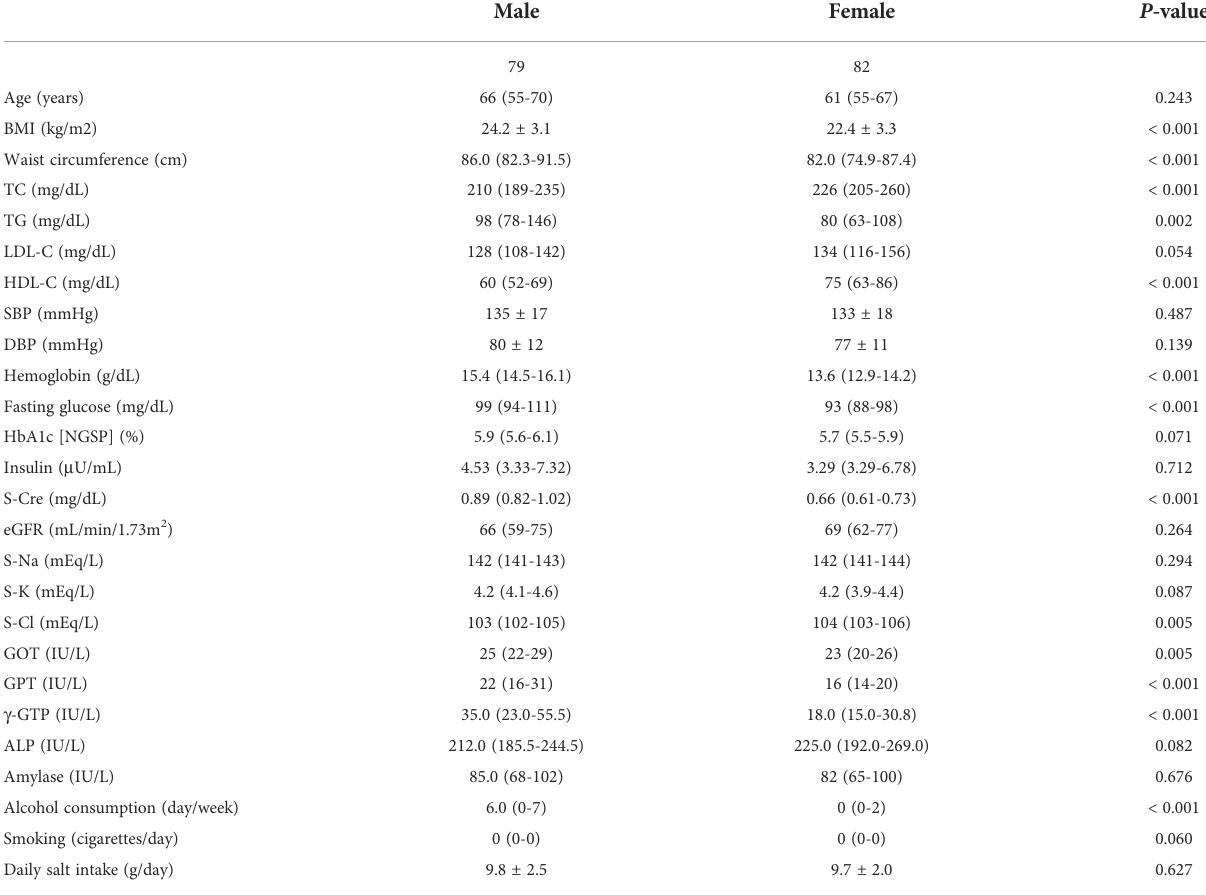
TABLE 1 Characteristics of study participants categorized by